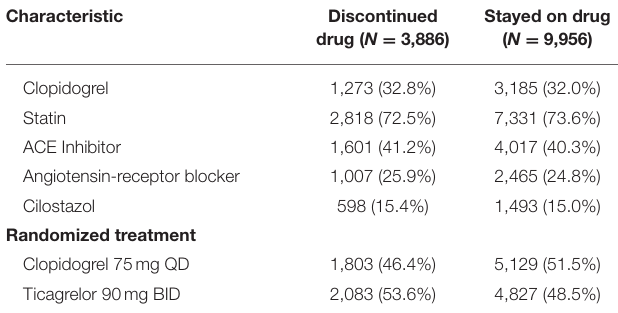
TABLE 1 | Baseline characteristics of patients with and without premature, permanent study drug discontinuation.